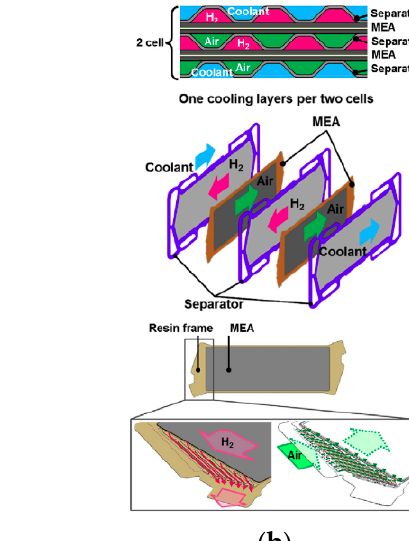
Figure 3. The seal member is integrated on the separator. ( a ) cross-sectional view of MEA [22]; ( b ) fuel cell structure and resin frame [25].